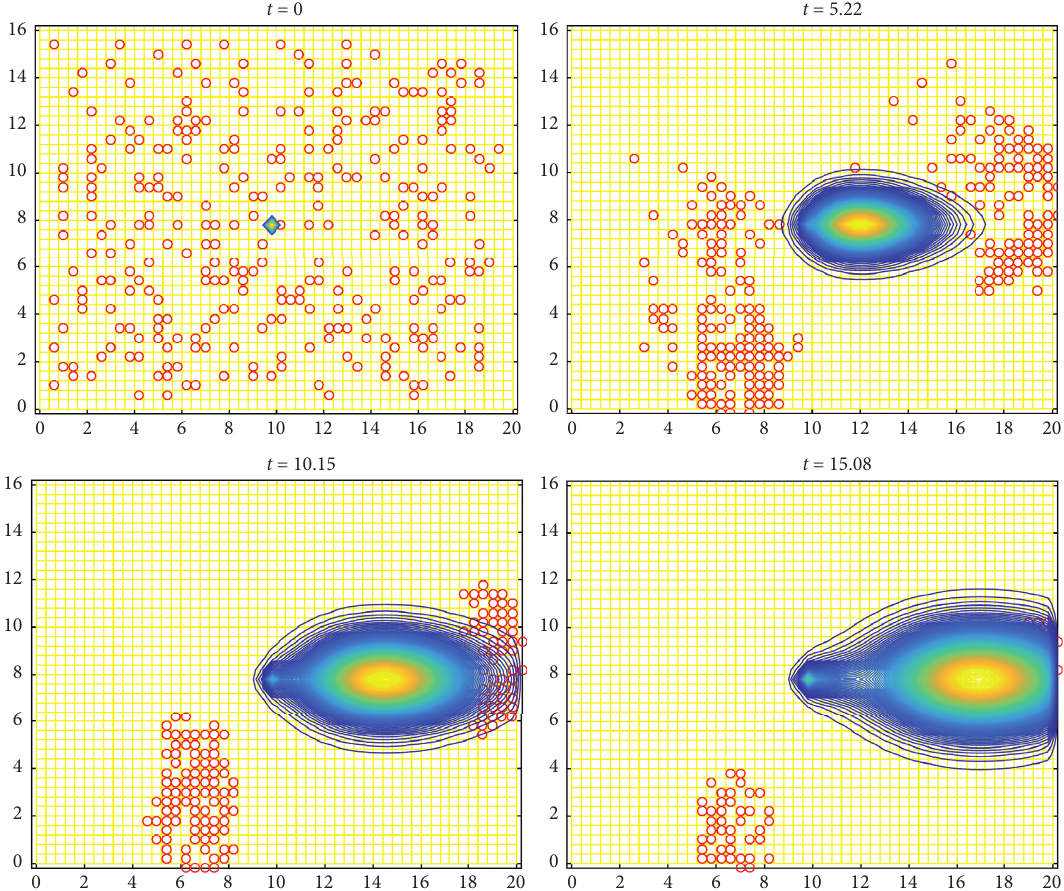
Figure 7: The movements of 300 pedestrians during smoke spreading, as the velocity field of the advection-diffusion is ( w equation (4) and the source is in the middle of the room.